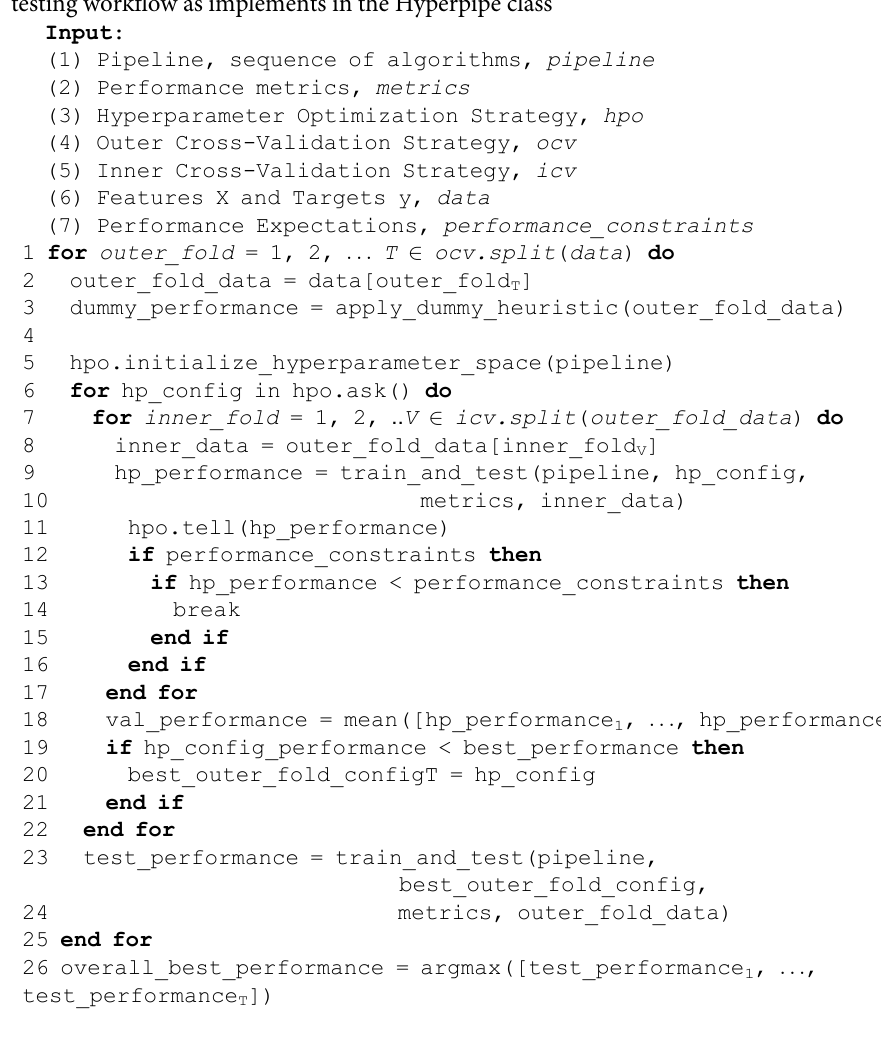
Algorithm 1 Pseudocode for PHOTONAI’s training, hyperparameter optimization